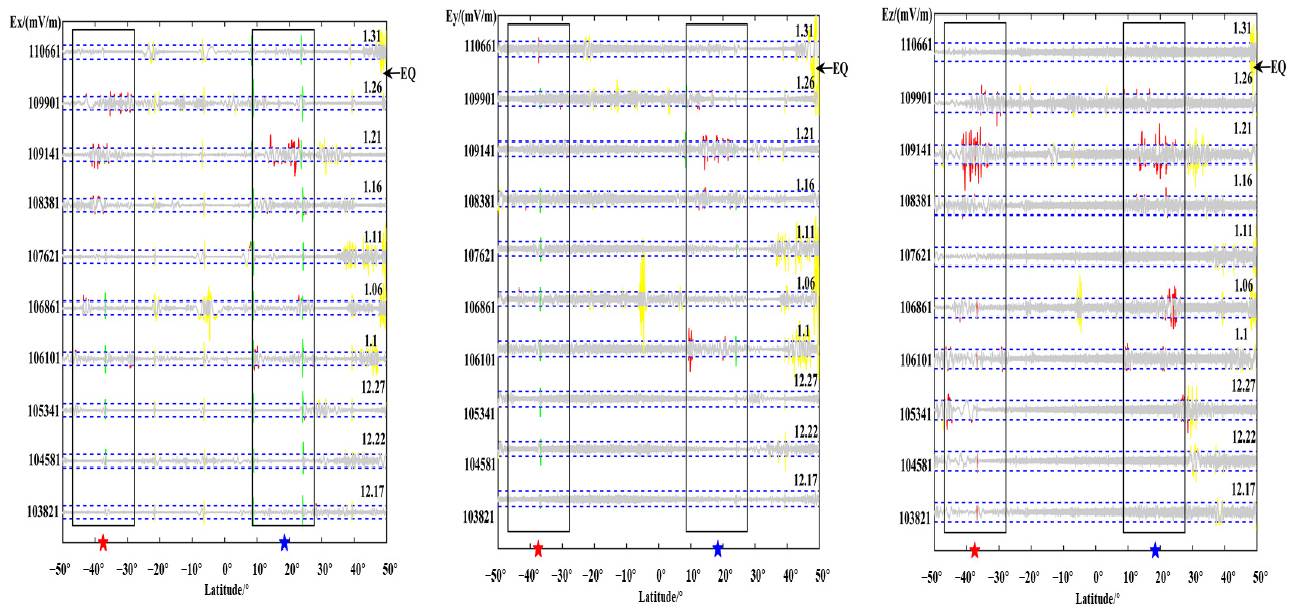
Figure 8. Orbit 109 , 901 and its revisited tracks.